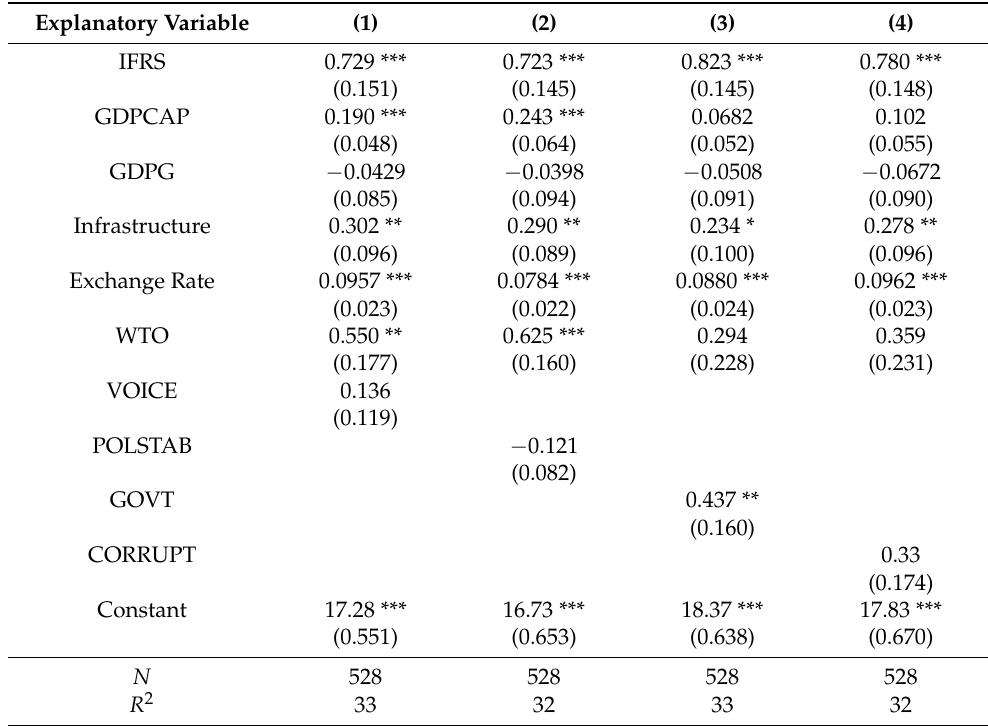
Table 4. PPML estimation results with one-period lags with individual time